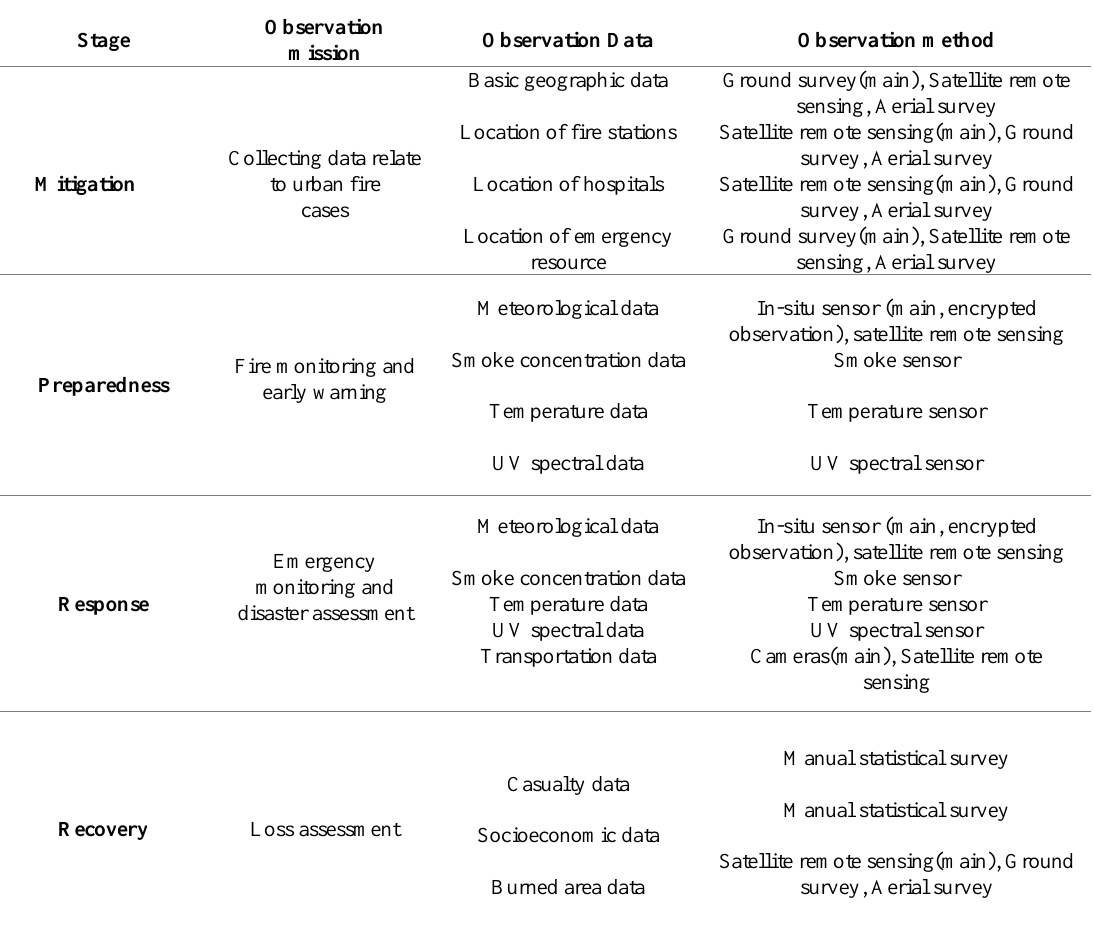
Table 1. Observation missions, data and methods in four